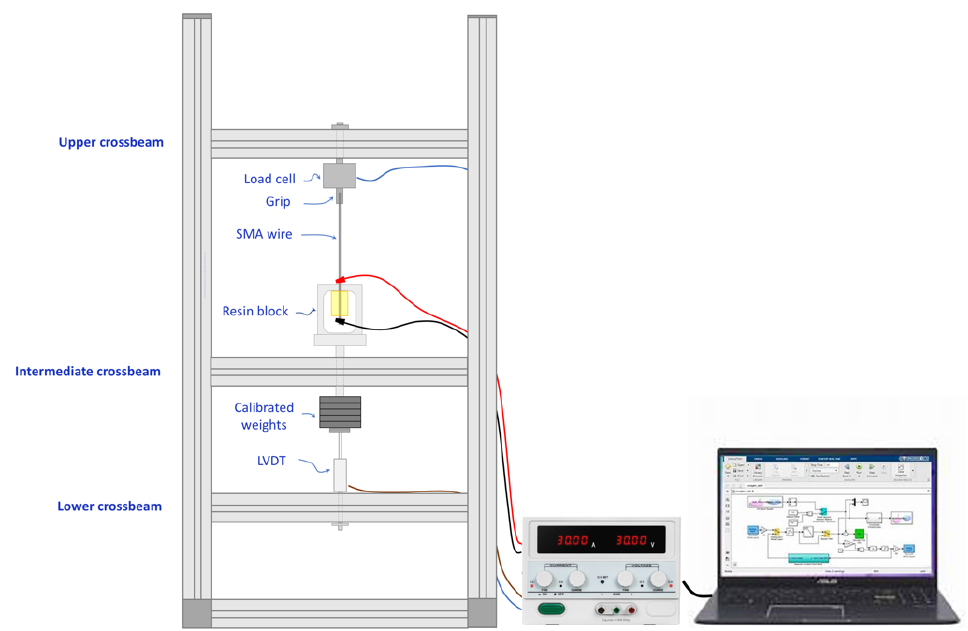
Figure 6. Testing rig for thermo-mechanical fatigue testing of SMA – polymer